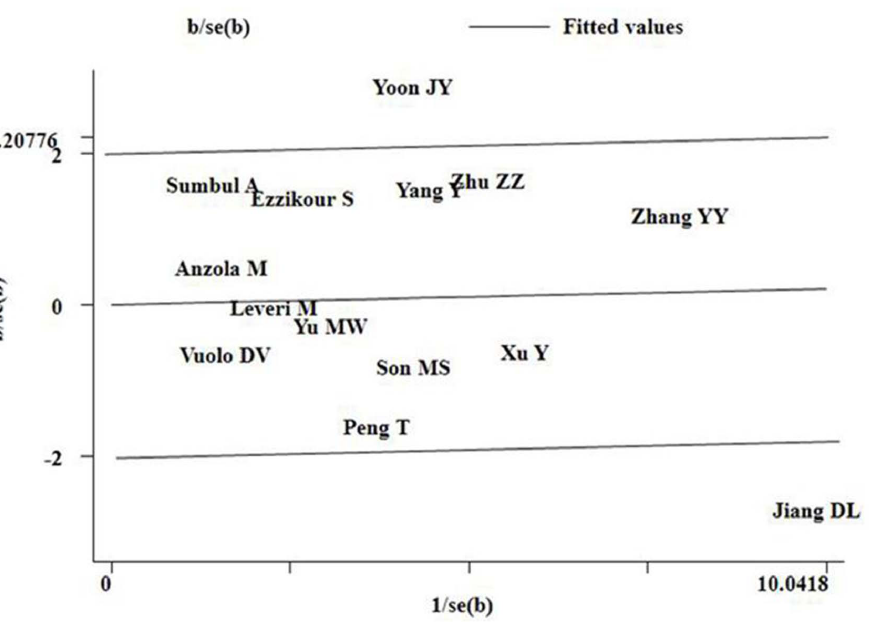
Figure 4. Galbraith plots of TP53 Arg72Pro polymorphism and HCC risk (additive model ProPro vs. ArgArg). The studies of Jiang et al. and Yoon et al. were spotted as outliers.